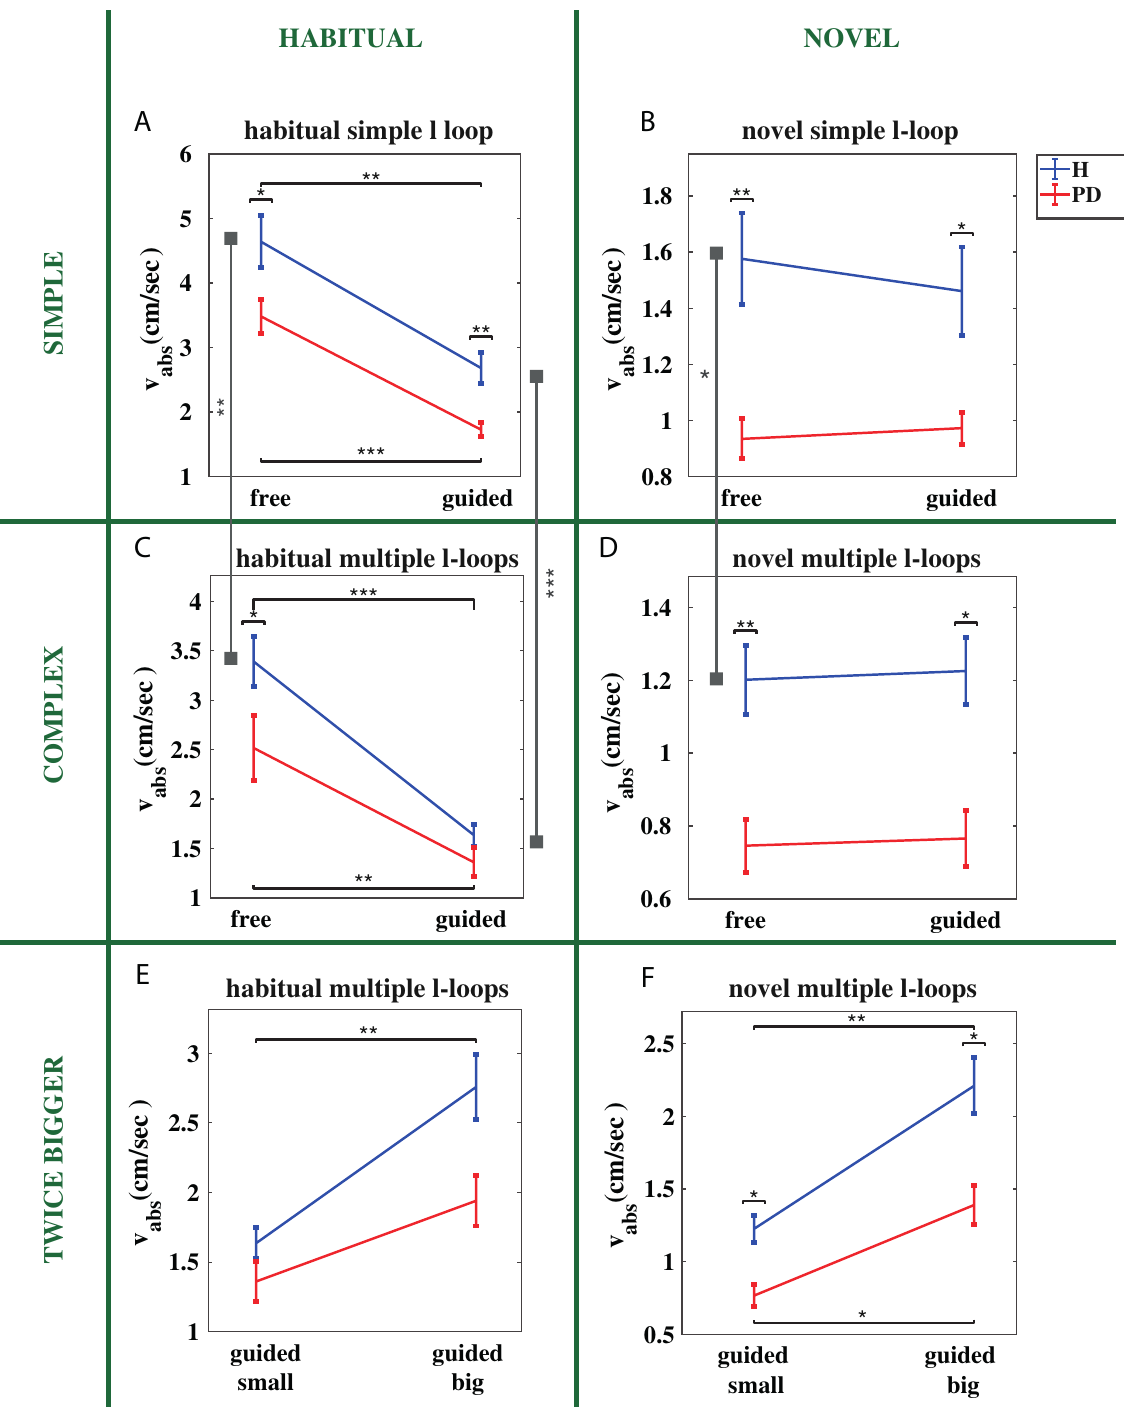
Figure 3. Absolute velocity (mean ± SEM) across PD patients (red lines) and H subjects (blue lines) for all conditions: ( A ) Habitual simple l-loop, ( B ) Novel simple l-loop, ( C ) Habitual multiple l-loops, ( D ) Novel multiple l-loops, ( E ) Habitual multiple l-loops, ( F ) Novel multiple l-loops. Grey and black lines indicate the results of t -tests that gave significant differences. Stars indicate the results of one-tailed t -tests corrected with the FDR procedure (* p < 0.05; ** p < 0.01; *** p <